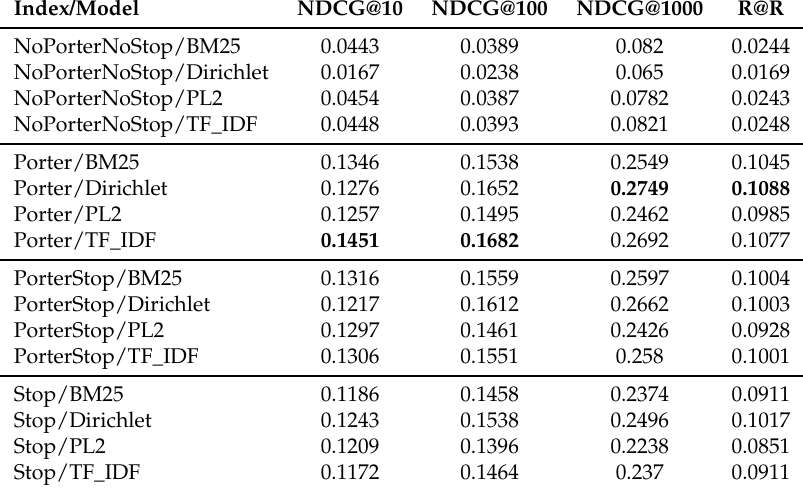
Table 3. NDCG at various cut offs and Recall@R for the different models for T1. The highest values are in